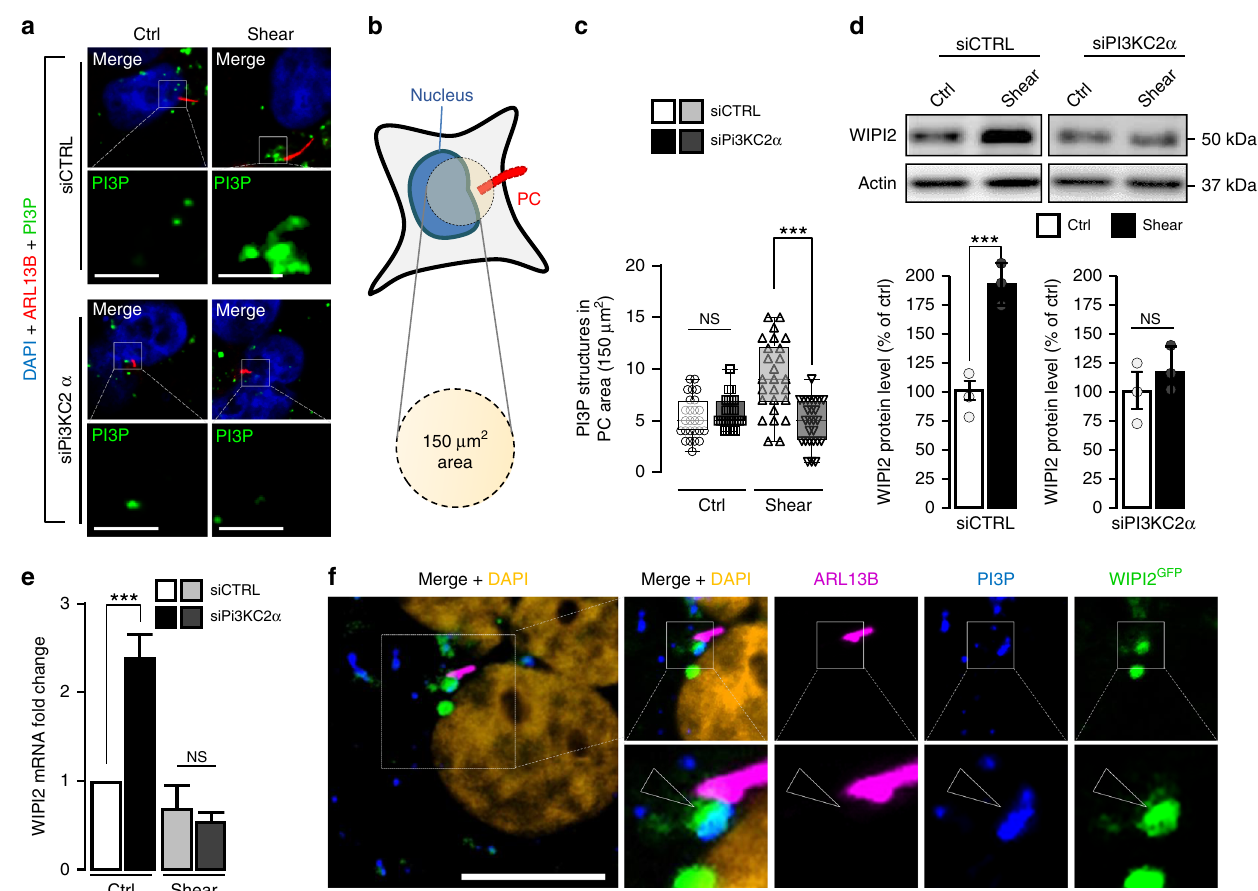
Fig. 2 Shear-stress-induced PI3P synthesis at the PC depends on PI3KC2 α . a Representative confocal images upon shear-stress conditions of PI3KC2 α knocked down HK2 cells (siPI3KC2 α ), compared to control cells (siCTRL), immunostained for ARL13B, PI3P (using FYVE-GST indirect recombinant peptide) and DAPI ( N = 80 cells, from fi ve independent experiments). Scale bar, 10 μ m. b Schematic drawing showing the 150 µ m 2 circular area centred at the cell nucleus used as identi fi er of the PC basal body area. c Quanti fi cation of the PI3P-positive structures at the PC area, as de fi ned in ( b ) and shown in ( a ), in siCTRL or siPI3KC2 α HK2 cells, upon static (ctrl) and shear-stress (96 h) conditions (mean ± SEM, N = 80 cells, from fi ve independent experiments). NS: not signi fi cant, *** p < 0.001 in two-tailed Student ’ s t test. d Western blot analysis and quanti fi cation of WIPI2 protein levels in lysates of polarized siCTRL or siPI3KC2 α HK2 cells, upon static (ctrl) and shear-stress (96h) conditions. Bar graph denotes average protein levels normalized to actin (mean ± SEM, from three independent experiments). NS: not signi fi cant, *** p < 0.001 in two-tailed Student ’ s t test. e WIPI2 mRNA levels quanti fi cations from total lysates of polarized siCTRL or siPI3KC2 α HK2 cells, upon static (ctrl) and shear-stress (96 h) conditions. Bar graphs denote fold change of average mRNA levels relative to ctrl and normalized to actin mRNA (mean ± SEM, from three independent experiments). *** p < 0.001 in two-tailed Student ’ s t test. f Representative confocal acquisition of WIPI2 GFP transfected HK2 cells upon shear-stress conditions immunostained for ARL13B, PI3P (using FYVE-GST indirect recombinant peptide) and DAPI showing PI3P and WIPI2 GFP colocalization at the base of PC (arrowhead). Scale bar, 10 μ